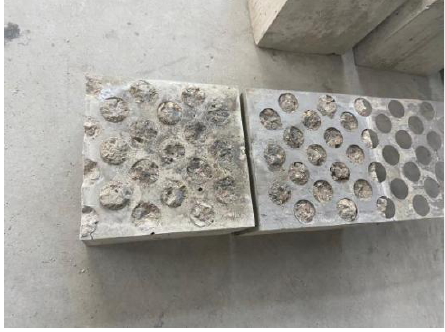
Figure 10. The second kind of destruction.